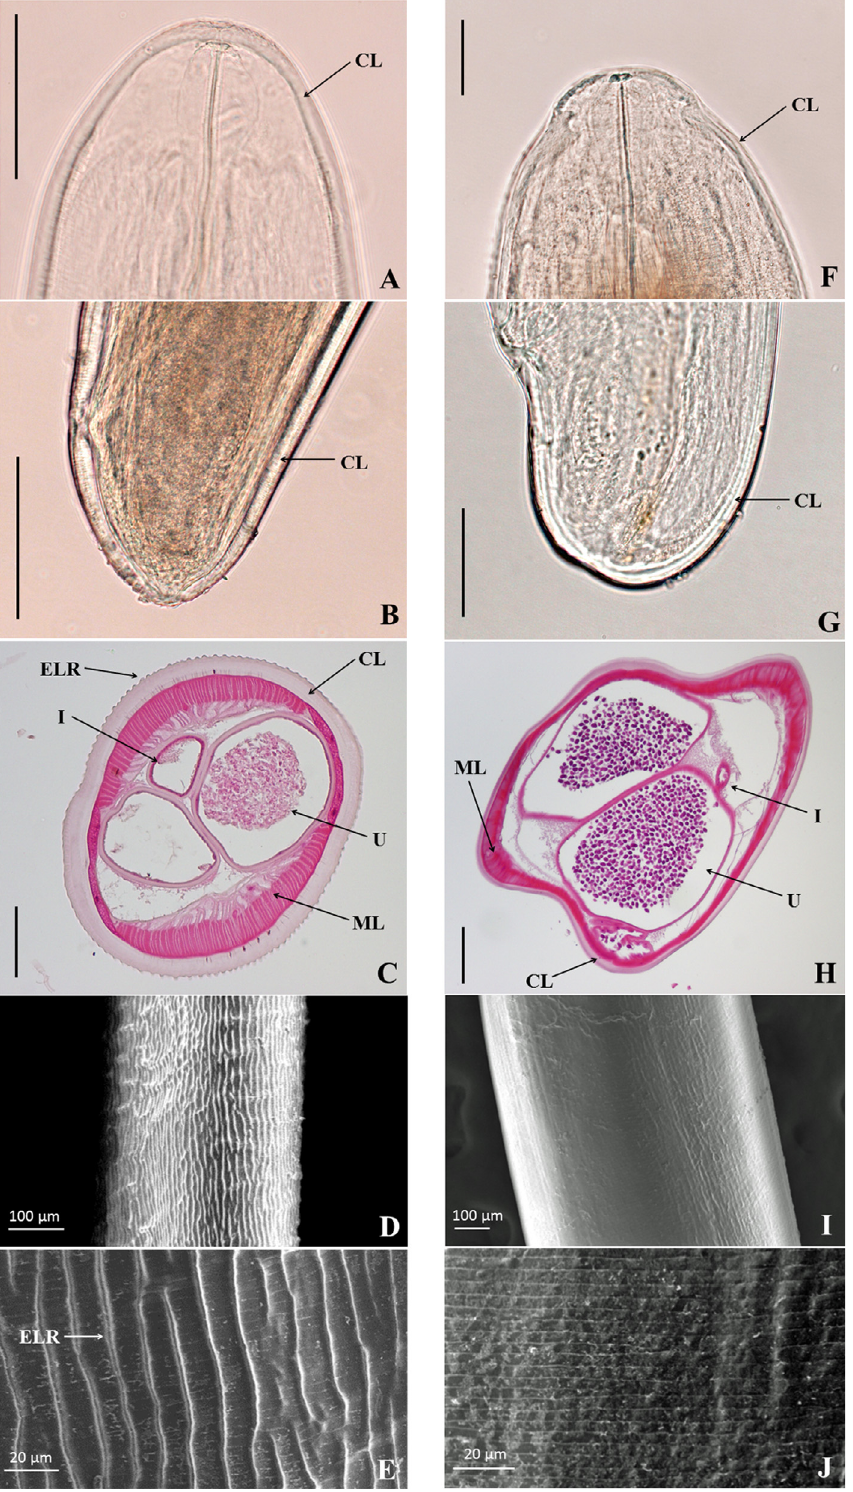
Figure 1. Morphological images of female adults of the Dirofilaria species isolated from the present case (left column, A–E) and Dirofilaria immitis (right column, F–J). A, F: direct images of the cephalic parts under an optical microscope. B, G: direct images of the caudal parts under an optical microscope. C, H: cross-sectional tissue sections (hematoxylin and eosin stain). D, I: low-magnification images of the body surfaces under a scanning electron microscope (SEM). E, J: high-magnification images of the body surfaces under SEM. Scales bars: A, B, C, F, G, 100 l m; H, 200 l m. CL, Cuticular Layer; ELR, External Longitudinal Ridge; I, Intestine; ML, Muscular Layer; U,